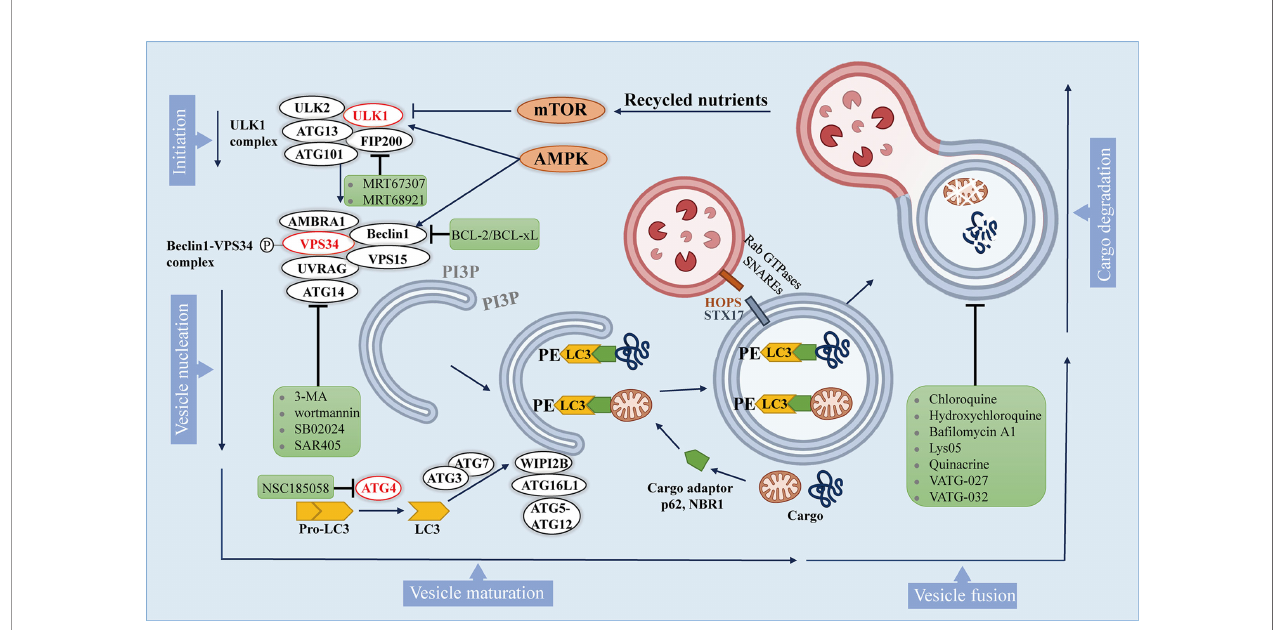
FIGURE 1 | The autophagy pathway and multiple stages can be inhibited. The autophagy pathway consists 5 steps. Intracellular membranes are prepared by initiation and vesicle nucleation to form AVs through the formation of PI3P on membranes. Next, LC3-I is conjugated to PE on emerging AVs. Subsequently, LC3 is docked with the cargo adapter so that the cargo can be loaded into the AVs. After AVs matures, it fuses with lysosomes to complete the degradation of cargo and the recycling of nutrients. Autophagy inhibitors are shown in green